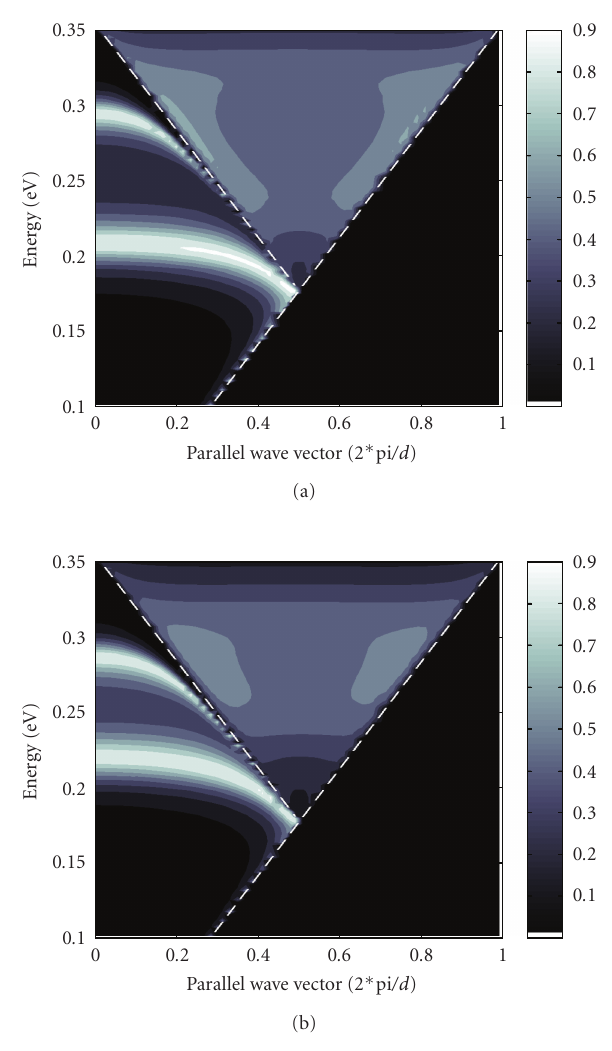
Figure 3: Photonic band structure of the surface plasmons respon- sible for the transmission resonances of gold gratings in vacuum with slit shape as (a) CDC with g = 100nm and (b) CDC with g = 50 nm. The grating parameters are fixed at d = 3.5 μ m, a = 0.5 μ m, and t = 3.0 μ m. Also, energetic positions seen in figures are (white dashed lines) of the SPP modes.